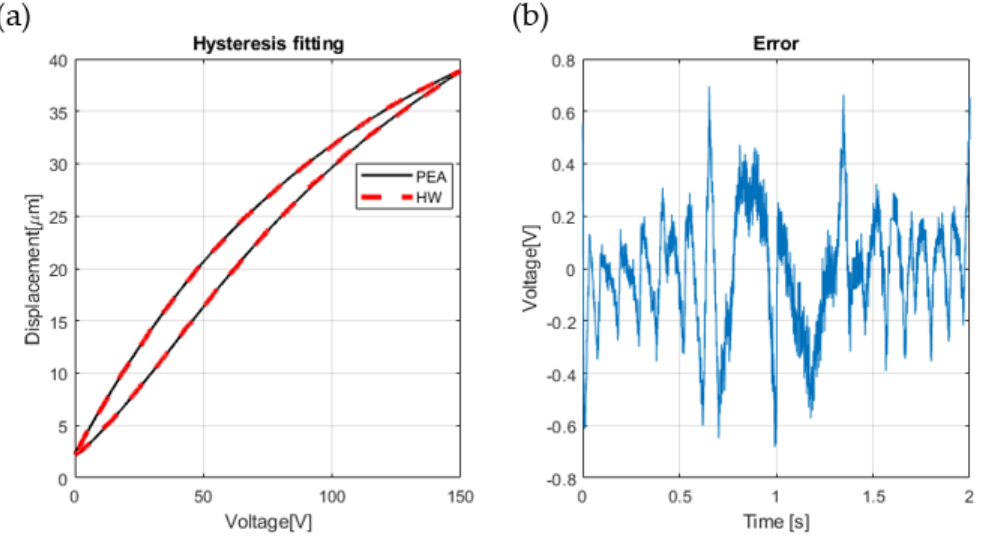
Figure 6. Hysteresis graph description where ( a ) corresponds to the fitting and ( b ) to the associated